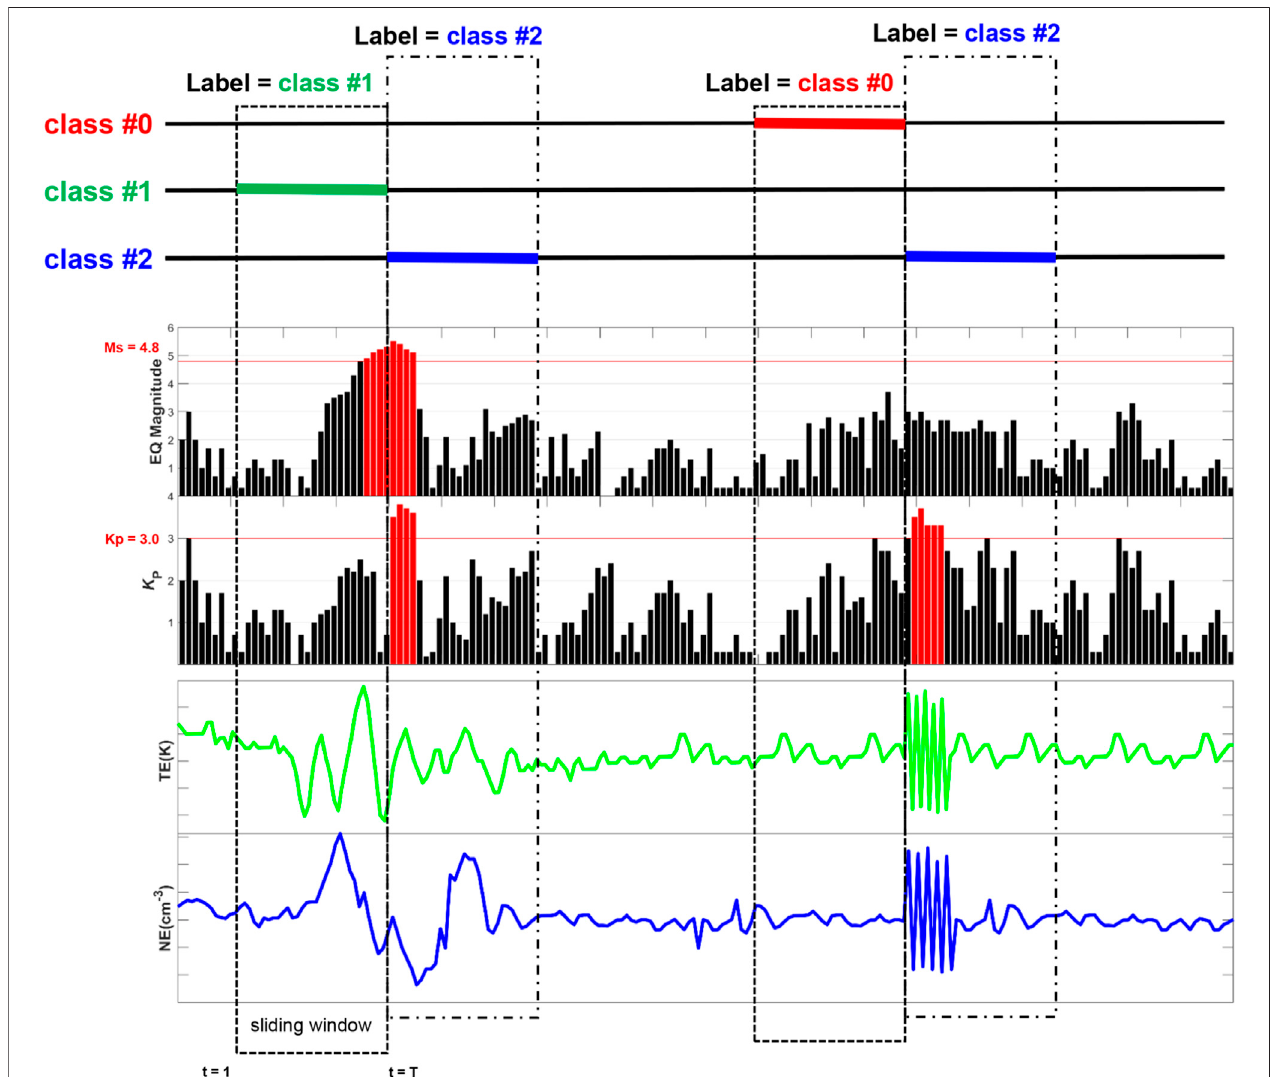
FIGURE1| Sequence labelingafter segmentingthedatawithaslidingwindow. ConsecutiveobservationsofNeandTearesegmentedbynon-overlappingsliding windows. T is the length of the window. Non-seismic data are labeled as 0 (class #0), seismic-related data are labeled as 1 (class #1), and data with a K p index > 3 are labeled as 2 (class #2), regardless of whether or not they are related to an